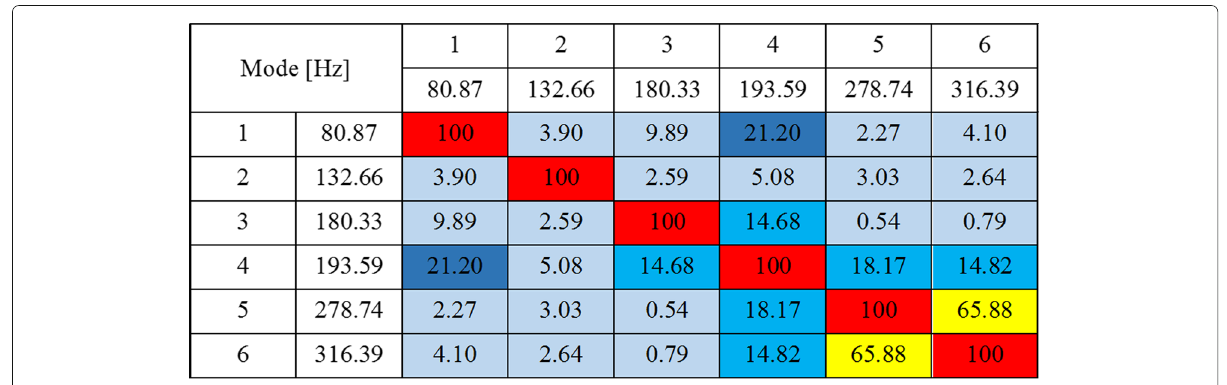
Fig. 17 Tabular view of the AutoMAC matrix for EMA mode shapes